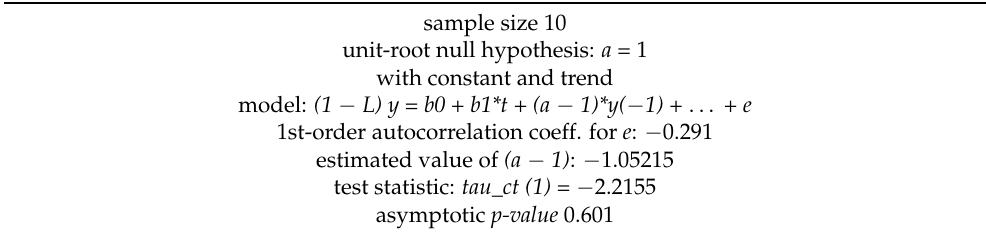
Table 1. Statistical properties of variables (ADF test) for S t including one lag of (1 − L) S t